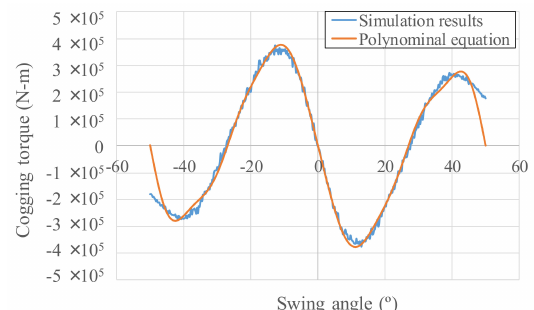
Figure 18. Cogging torque simulation and regression results.